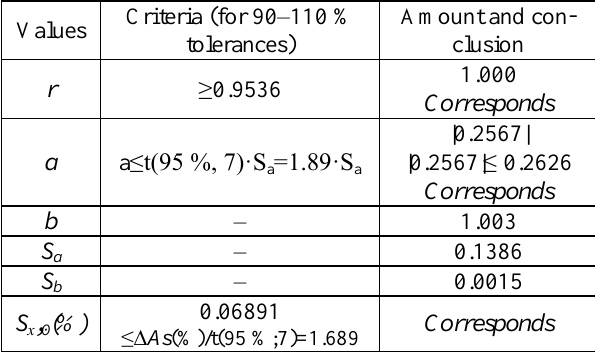
Parameters of linear dependence